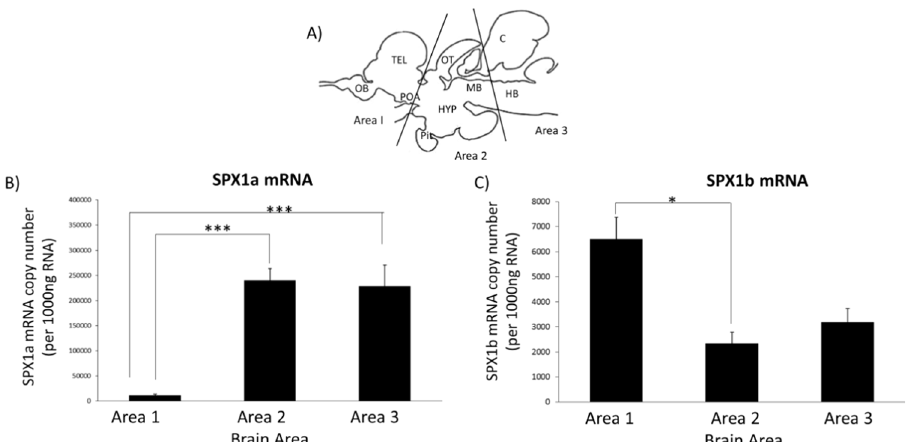
Figure 2. Distribution of SPX1a and SPX1b in the brain of Nile tilapia. ( A ) Dissection of the brain into 3 areas. OB, olfactory bulb; POA, preoptic area; TEL, telencephalon; OT, optic tectum; HYP, hypothalamus; PIT, pituitary; MB, midbrain; C, cerebellum; HB, hindbrain. ( B ) Distribution of SPX1a mRNA is highest in area 2. ( C ) Distribution of SPX1b is highest in area 1. ( * p < 0.05, *** p < 0.001).